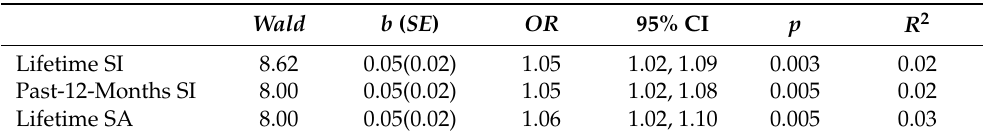
Table 2. Binary logistic-regression analysis examining problematic cannabis use as a predictor of suicide outcomes.